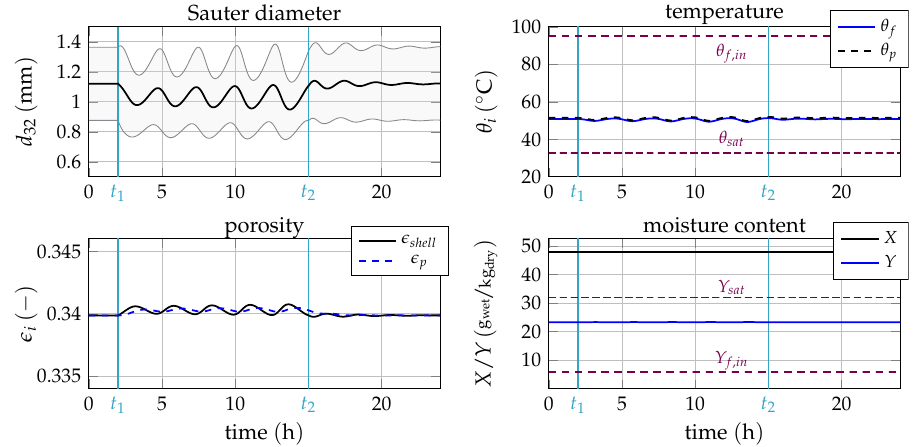
Figure 8. Simulation results of the first scenario: the setpoint switch of mean size of milled particles µ mill from 0.8 mm to 0.7 mm at t 1 = 2 h leads to the arising of self-sustained oscillations. After the reset of µ mill at t 2 , the oscillations decay and the dynamic system reaches steady state again. Alterations of A p change the heat transfer between fluidization medium and particles, ˙ Q fp . Thus, the temperatures of particles θ p and fluidization medium θ f vary, leading to a change of the drying process. As a consequence, the moisture contents X and Y change, inducing a variation of the drying potential η . As e shell depends on η , the porosity of the shell changes, as well. This leads throughout simulation time to a change of the apparent particle porosity e p and, as a consequence, to a variation of the particles density ρ p . At t 2 = 15h, the parameter µ mill is reset to 0.8 mm. As a consequence, the oscillations decay such that the system settles, after sufficient long simulation time, at steady state again. Thereby, the steady state and the initial state share the same values. 3.2. Variations of Injection Rate As depicted in Figure 6, an increased injection rate ˙ m inj leads to a more porous particle, surface, resulting in a higher shell porosity e shell . To reproduce this experimental observation by simulations, the second scenario was introduced: the injection rate ˙ m inj was increased from 40 kg / h to 50 kg / h at t 1 = 2 h and, at t 2 = 15 h, reset to the default value. The increase of the injection rate ˙ m inj at t 1 raised the amount of supplied salt and solvent. While the first had an impact on the particle growth and thus on normalized particle size distribution q ( t , L ) , as well as Sauter diameter d 32 , hardly observed in simulation results shown in Figures 7b and 9, the second lead to significant variations of the thermal conditions. Since more solvent was injected, the particles moisture X increased from 47.8 g wet / kg dry to 49.1 g wet / kg dry . Considering Equation (18), this led, as long as the second period drying proceeds, to an enhanced evaporation rate ˙ m evap . As a consequence, the moisture of the fluidization medium Y was raised from 23.3 g wet / kg dry to 27.6 g wet / kg dry . The resulting drop of the drying potential η led, in accordance with Equation (3), to a higher shell porosity e shell . As can be seen in Figure 9, the thermal conditions discussed so far are characterized by a fast transition from the initial to the new steady state. The transition of the apparent particle porosity e p to the new steady state is much slower. This can be explained by the nature of e p : the apparent particle porosity is an integral value. Therefore, all particles with an apparent porosity e p differing from current shell porosity e shell have to be removed from the process. After that, the apparent particle porosity e p and the porosity of the shell e shell share the same value.